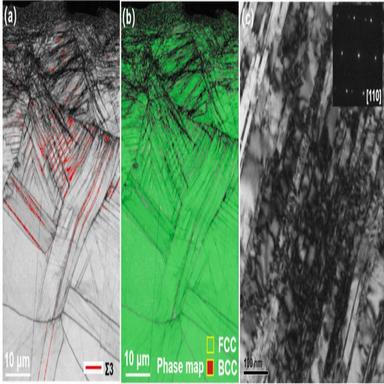
(a) EBSD band contrast and twin boundaries overlaid map and (b) phase map of the deformation layer; (c) bright-filed TEM image of the region which was 10 μm beneath the surface, selected area electron diffraction pattern of this region was shown as inset.